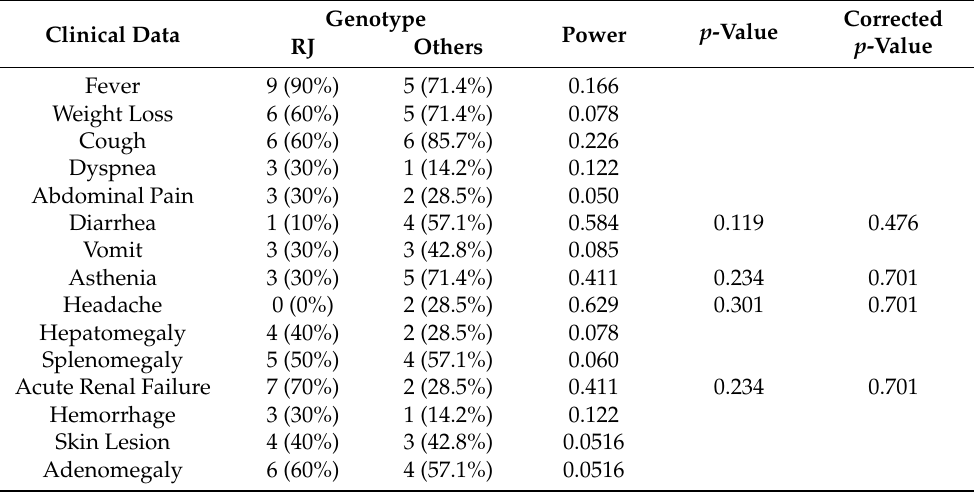
Table 2. Clinical features of histoplasmosis cases distributed among different genotypes